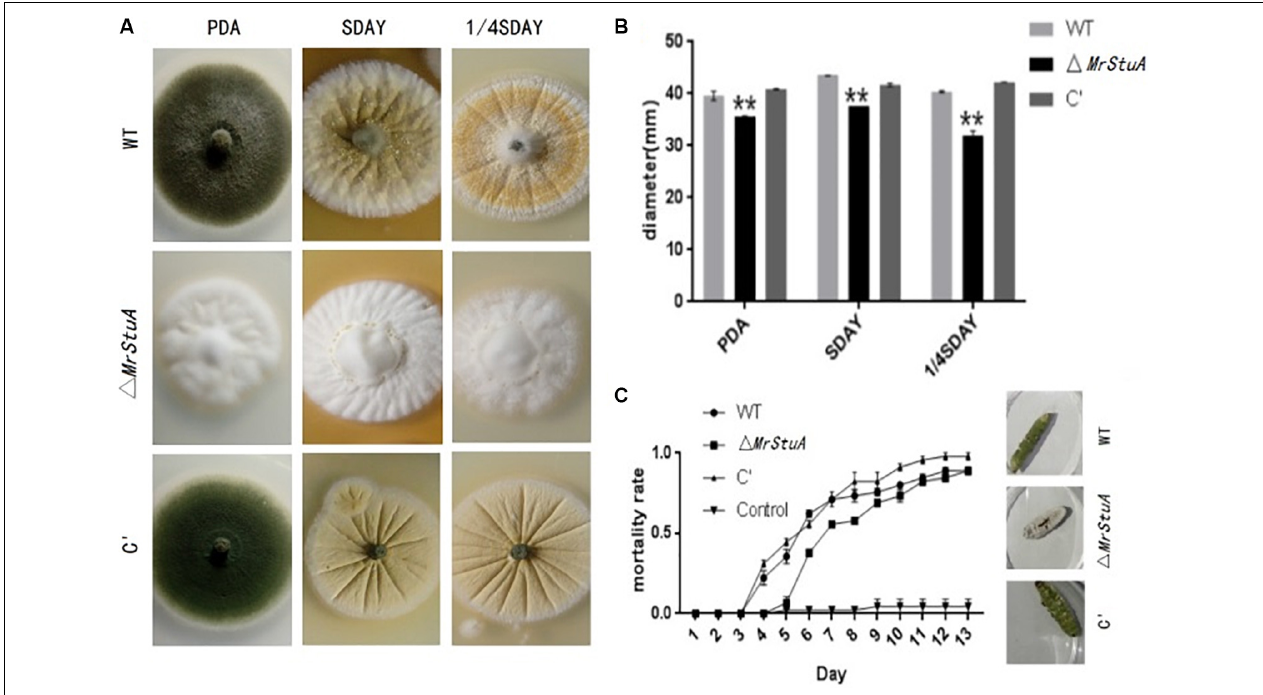
FIGURE 4 | Effect of the MrStuA gene on other phenotypic traits. (A) Colonies from each strain grown on solid PDA, SDAY, and 1/4SDAY. (B) Radial growth rate of each strain on solid PDA, SDAY, and 1/4SDAY. (C) Virulence curves of each strain. Error bars are standard error of at least three independent experiments. Student’s t -test: ∗ p < 0.05, ∗∗ p <